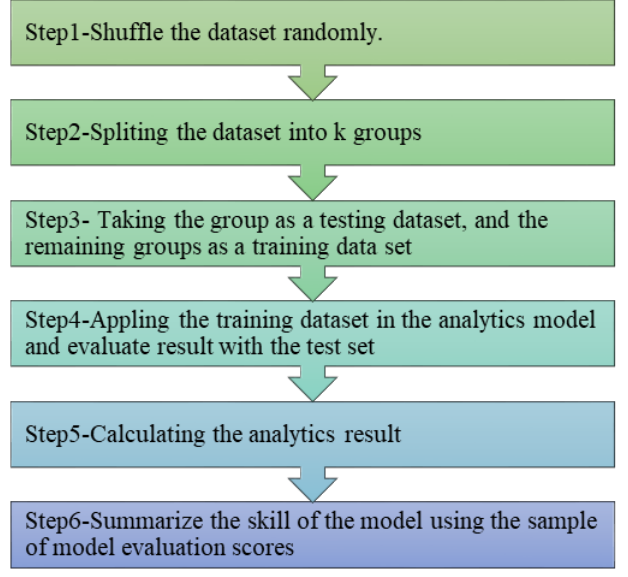
Figure 8. Procedure of K-fold cross-validation.